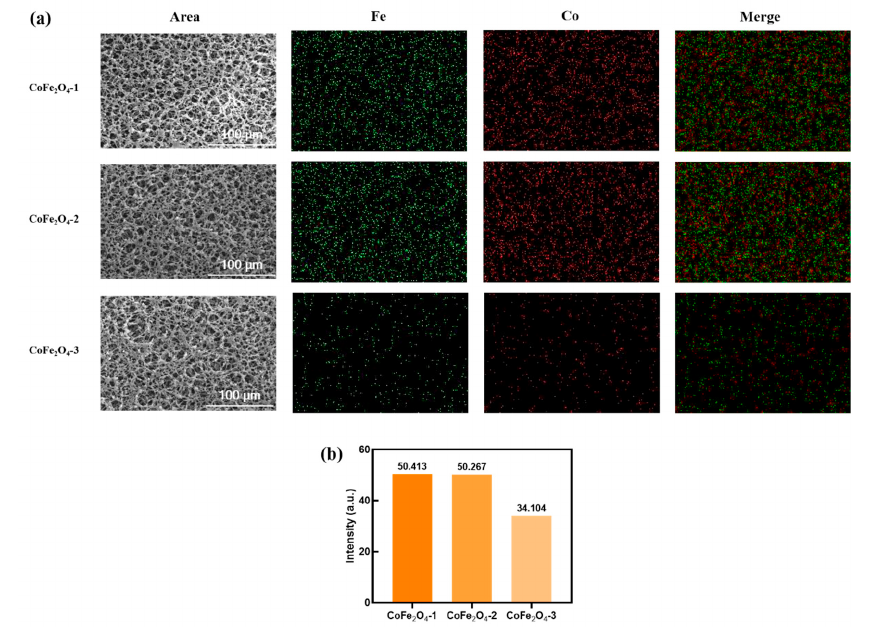
Figure 5. Characterization of CoFe 2 O 4 nanozymes on NC membrane by SEM. ( a ) Middle part of blank NC membrane. ( b ) Bo tt om part of blank NC membrane. ( c ) Middle part of CoFe 2 O 4 -1-NC membrane. ( d ) Bo tt om part of CoFe 2 O 4 -1-NC membrane. ( e ) Middle part of CoFe 2 O 4 -2-NC mem- brane. ( f ) Bo tt om part of CoFe 2 O 4 -2-NC membrane. ( g ) Middle part of CoFe 2 O 4 -3-NC membrane. ( h ) Bo tt om part of CoFe 2 O 4 -3-NC membrane. Red arrows are used to point out the nanozymes.